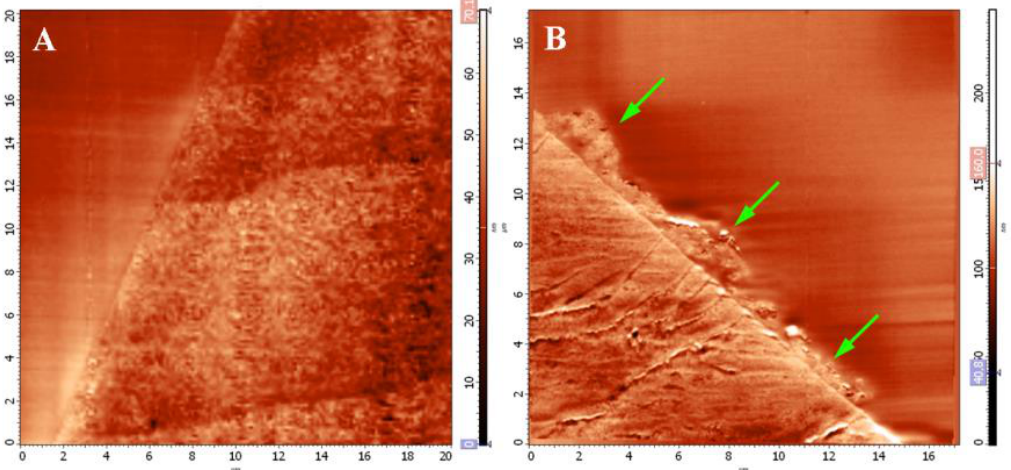
Figure 4. SPM images of the surface of the cross-section of the scaffold in the form of a film. ( A ) SF scaffold (scanning area 20 × 20 μm), ( B ) SF-MP scaffold (scanning area 17 × 17 μm). Microparticles of decellularized tissue are indicated by arrows.